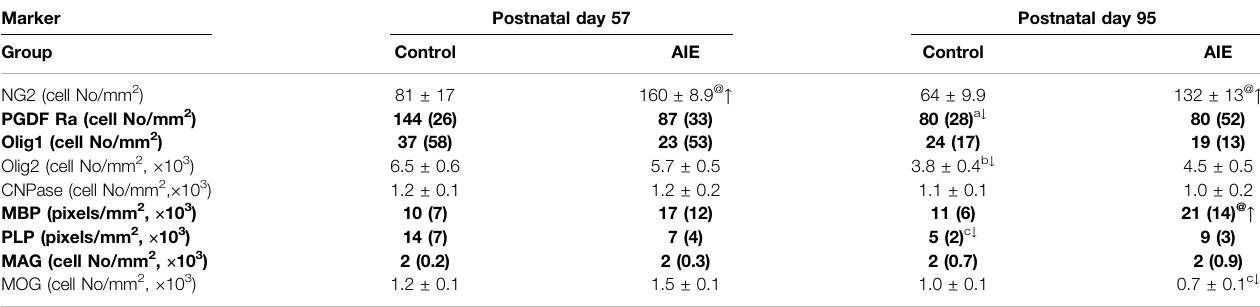
TABLE1| Frontalcorticalwhitematter,ratforcepsminorofthecorpuscallosum(fmi)oligodendrogenesismarkersatP57andP95:Effectsofadolescentintermittentethanol (AIE) exposure. Marker Group